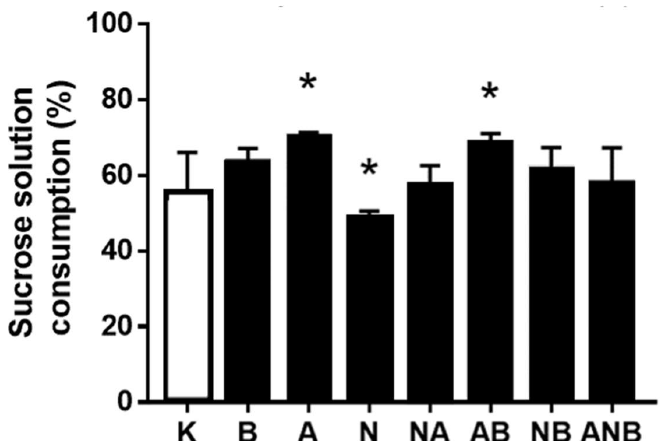
Figure 8. Sucrose solution consumption day 1 (%). Ketamine-induced sucrose consumption is shown in the sucrose preference test (SPT), mean values, and 95 percent confidence intervals. Su-